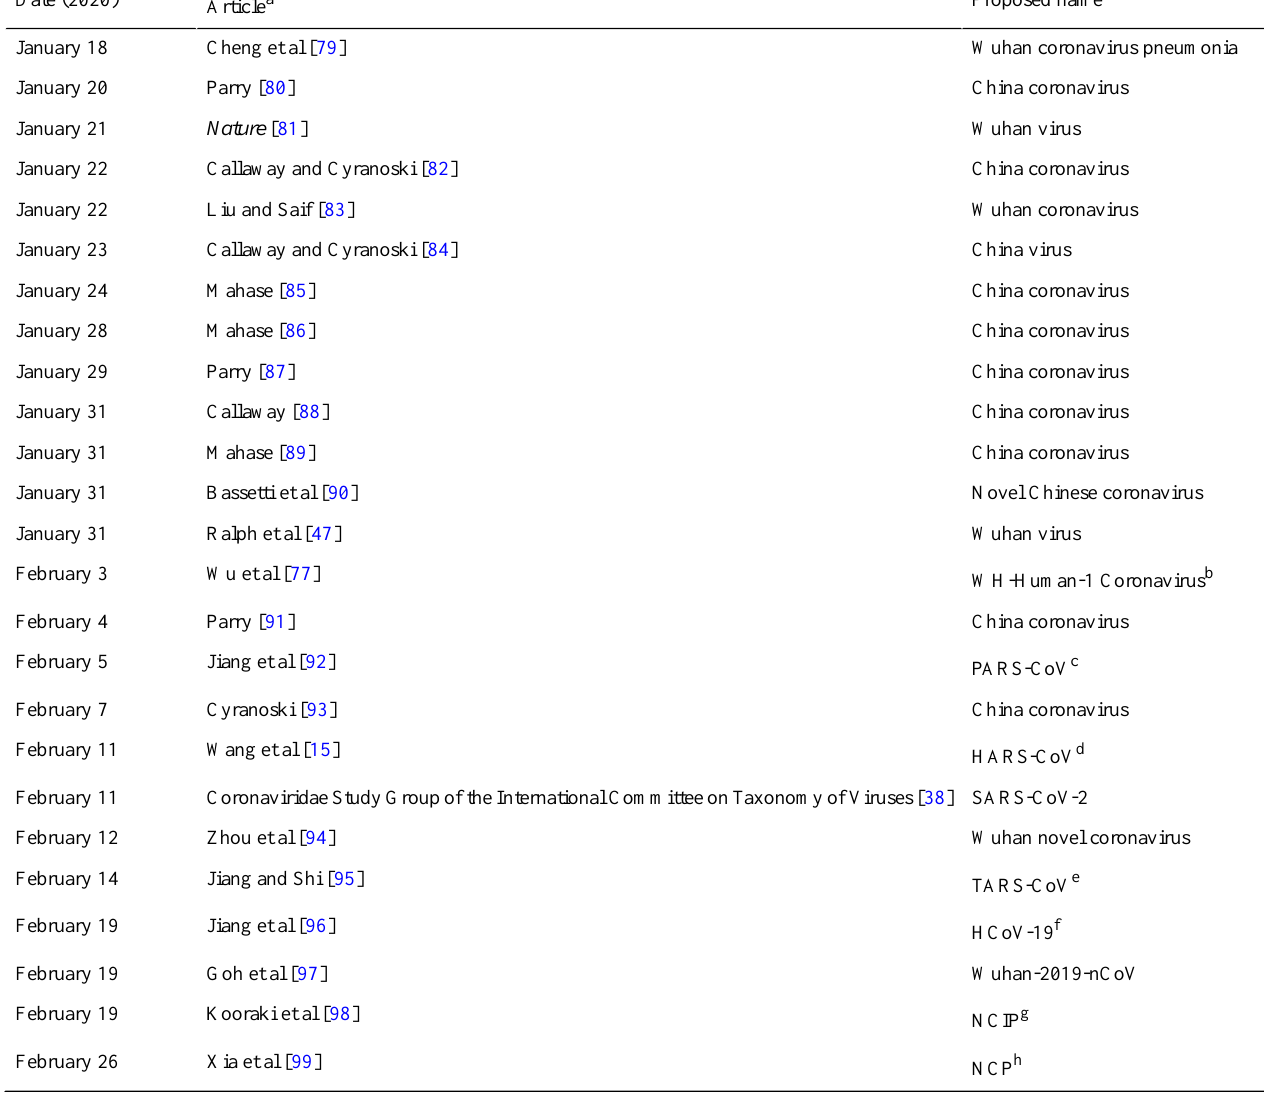
Table 1. Chronological list of published articles with multifarious proposed